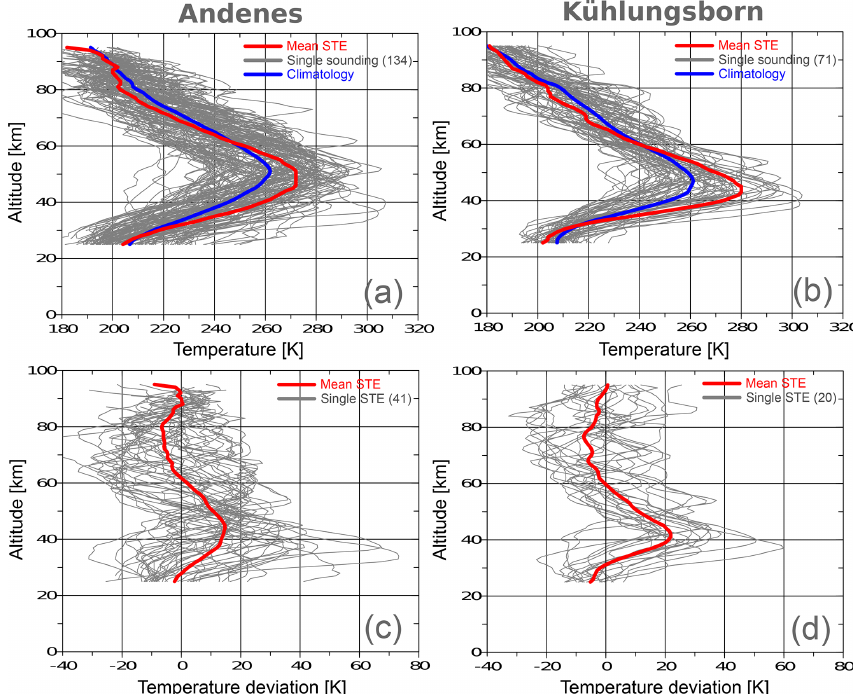
Figure 2. (a, b) Vertical profiles (grey lines) of all nighttime lidar temperature measurements between 2002 and 2012 at Andenes (a) and Kühlungsborn (b) and their respective long-term mean (blue line). (c, d) All detected STE profiles (grey lines) with subtracted long-term winter mean derived from lidar measurements. The red line represents in all plots the respective mean STE profile.